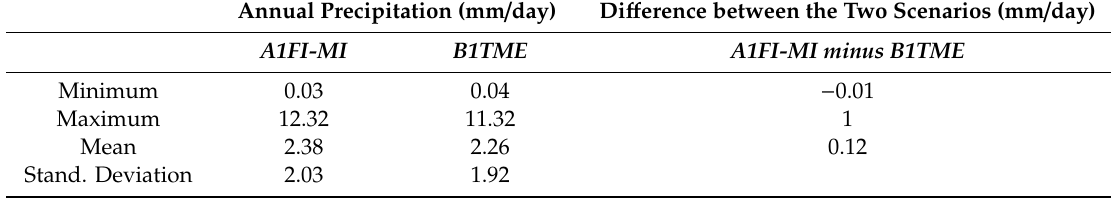
Stand. Deviation